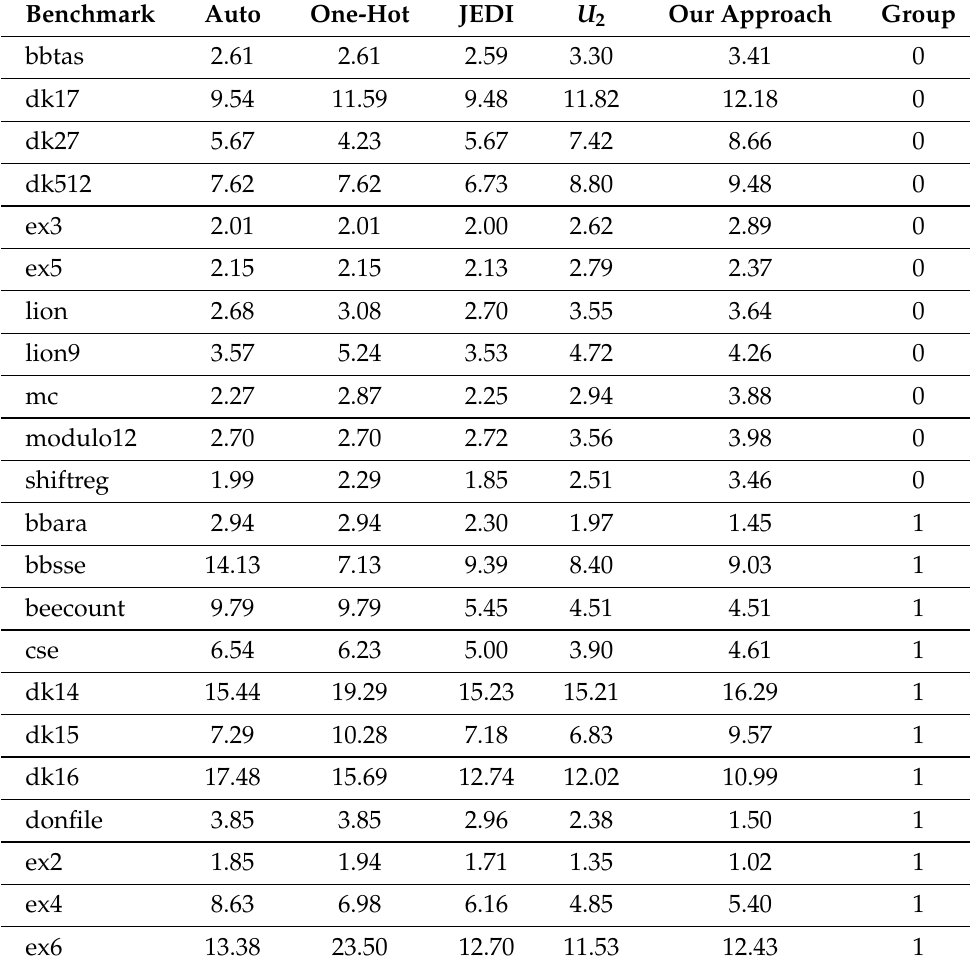
Table 20. Experimental results (power–time products,